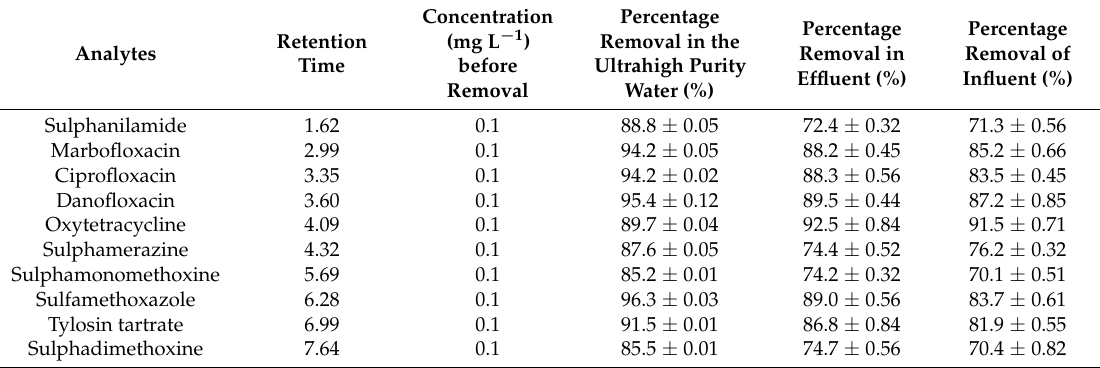
Table 2. Removal efficiency of water-soluble proteins in a real wastewater sample spiked with 2 mg L − 1 of the standard solution (effective concentration was 0.1 mg L − 1 ) (n =